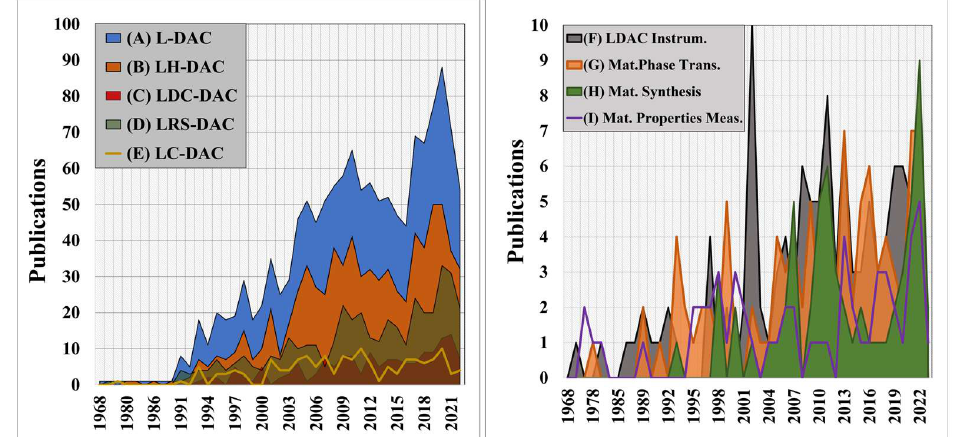
Figure 1. At left, ( A ) total annual scientific production for all L-DAC studies driven by UV-IR lasers [blue], ( B ) laser-heated diamond anvil cell (LH-DAC) articles where laser heating was employed for materials modification [orange], ( C ) laser-driven dynamic compression diamond anvil cell (LDC- DAC) experiments [red], ( D ) laser-induced reactive synthesis diamond anvil cell (LRS-DAC) articles where laser-induced reactive synthesis occurred [green], and ( E ) laser-based characterisation (LC- DAC) experiments, e.g., laser spectroscopy [yellow line]. At right, a breakdown of L-DAC articles focused on: ( F ) L-DAC instrumentation and hardware improvements [grey], ( G ) equation of state, phase transitions and phase mapping of materials [orange], (H) materials synthesis [green], and (I) material property measurements at high pressures and temperatures [purple line].